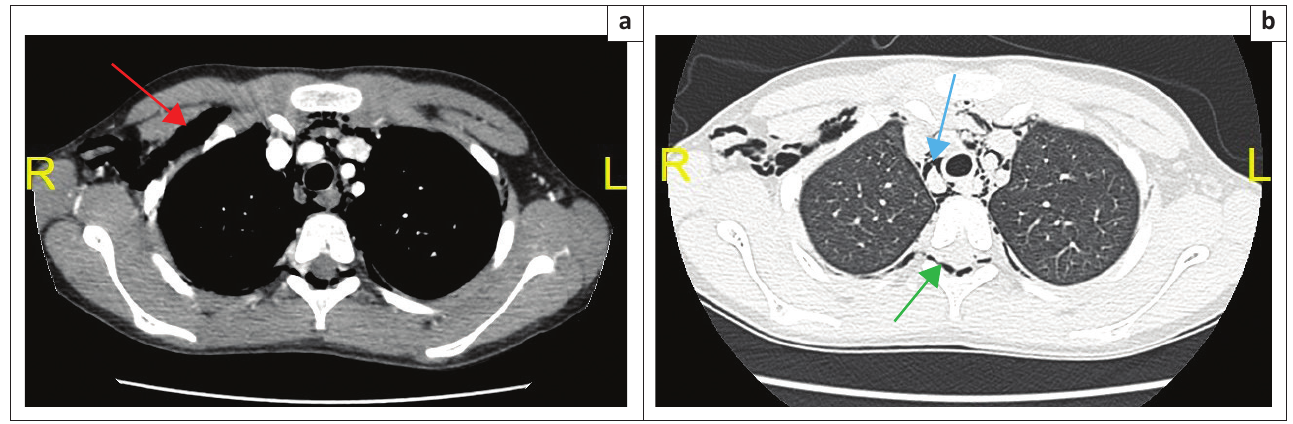
Source : Image utilised from picture archiving and communication system (PACS) of Jackpersad and Partners Inc FIGURE 2: (a and b) Axial post contrast (CT) scan, soft tissue and lung settings, respectively, demonstrating subcutaneous emphysema (red arrow), pneumomediastinum (blue arrow) and epidural emphysema (green arrow).